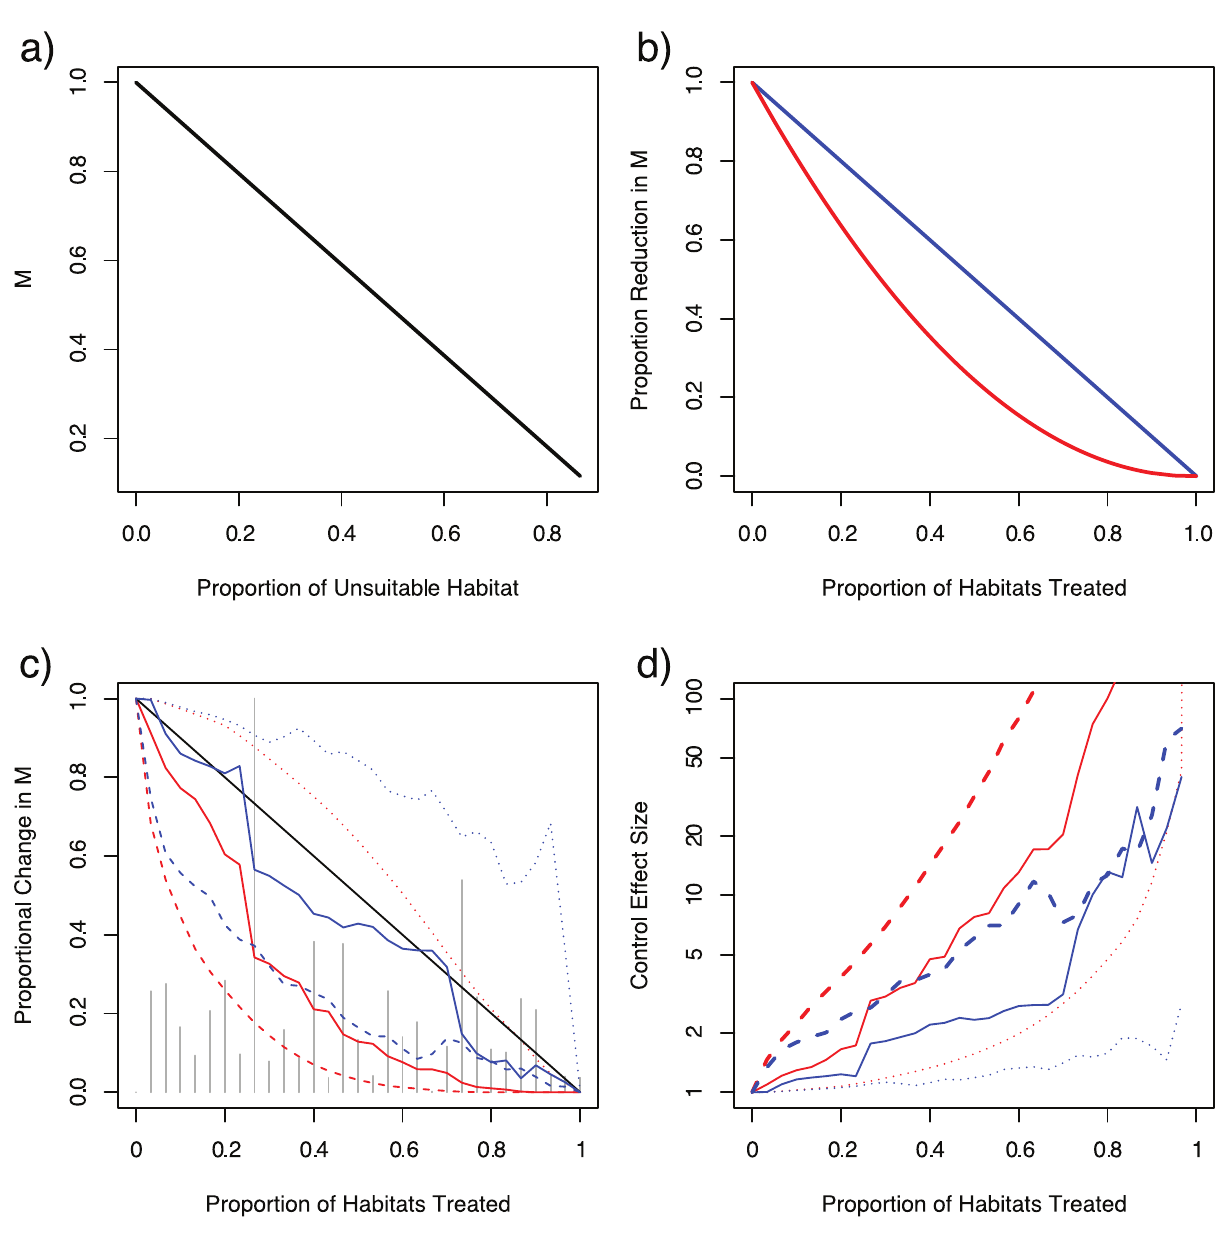
Figure 3. The ‘‘effect size’’ of LSM in relation to coverage tend to be either linear or quadratic depending on whether eggs are laid in ‘‘treated’’ habitats and how well LSM is targeted. a ) Holding the total number of productive pools constant, adult mosquito population density declines as the number of unproductive pools increases and absorb eggs. b ) The ‘‘egg sink’’ effect gives a non-linear effect to LSM if adult mosquitoes continue to lay eggs in the treated pools, so that treating 50% of the pools reduces adult density by 75%, and treating 75% of the pools reduces adult density by 95% (red). If adult mosquitoes do not lay eggs in the treated pools, however, then reductions in mosquito density are proportional to the % of habitat treated (blue). c ) The change in adult mosquito density due to LSM in highly heterogeneous habitat as a function of the proportion of habitats treated depending on whether the adults lay eggs in treated pools (red) or avoid treated pools (blue), and depending on whether LSM was done in one particular random order (grey spikes), perfectly efficiently targeted (dashed lines), or perfectly inefficiently targeted (dotted lines). The black line represents a linear response with respect to coverage. d ) For the same graphs as 3c, the effect sizes are plotted on a semi-log scale to highlight the benefits of LSM at high coverage. The best case for this system, with efficient targeting and egg-sink effects, predicts a hundred-fold (99%) reduction in mosquito density for 60% coverage. These benefits also get larger for higher coverage and show that there is enormous potential for LSM to reduce transmission through targeted repeated application of modern